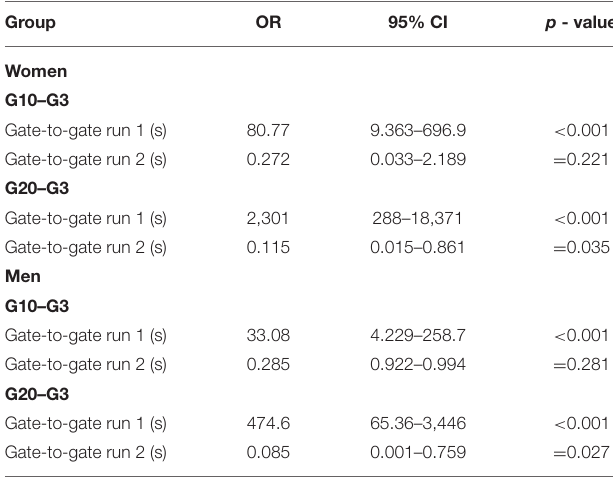
TABLE 2 | Multi-nominal logistic regression for gate-to-gate times in Giant Slalom FIS World Cup 2005–2020.